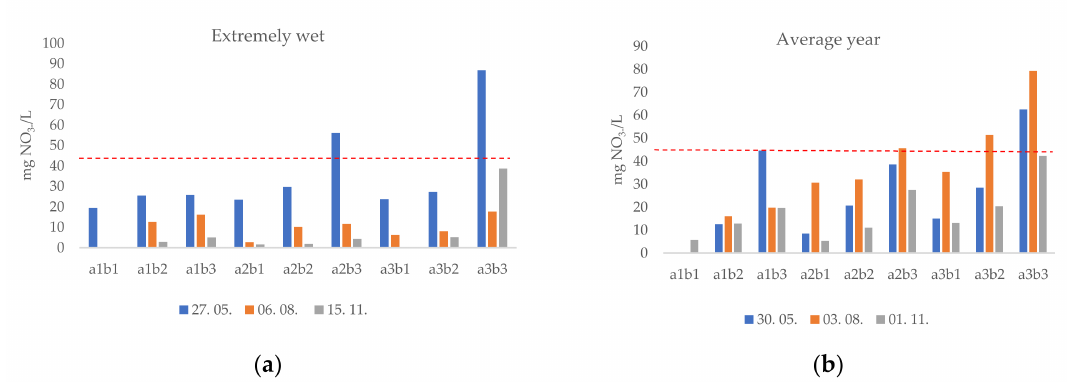
Figure 11. Nitrate leaching in the ( a ) extremely wet and ( b ) average years for different irrigation levels (a1 = rainfed, a2 = 60–100% FC, and a3 = 80–100% FC) and N fertilizer rates (b1 = 0 kg N ha − 1 , b2 = 100 kg N ha − 1 , and b3 = 200 kg N ha − 1 ).